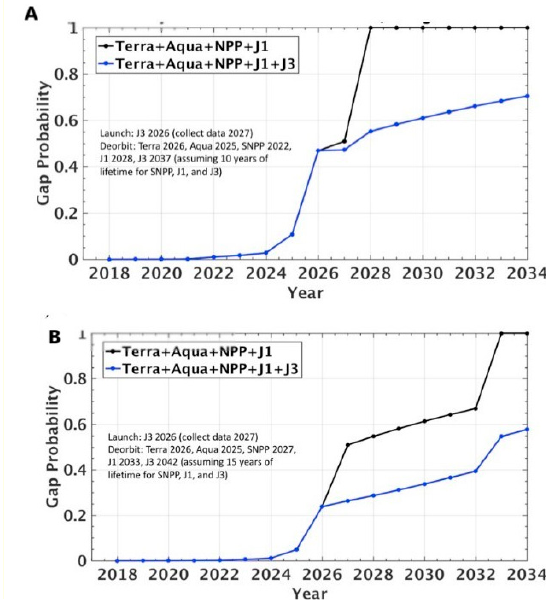
Figure 2. Analysis of the gap probability for ( A ) 10 years and ( B ) 15 years of mission lifetime for the Suomi National Polar-orbiting Partnership (SNPP), J1 and J3. Plots courtesy of Norman Loeb.